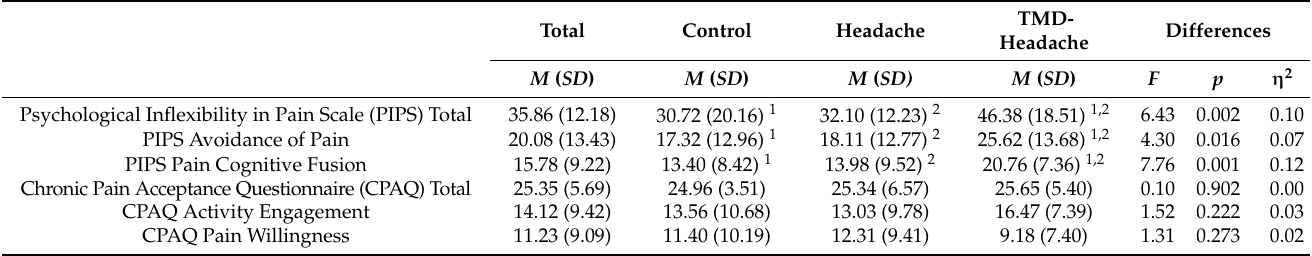
Table 2. Descriptive statistics for psychological variables in pips and CPAQ-8